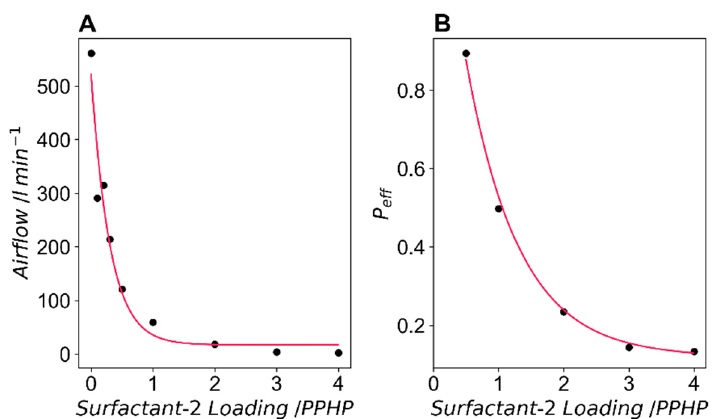
Figure 8. ( A ) Airflow through the foams at constant pressure of 125 Pa as a function of the loading of surfactant-2 where the solid line indicates an exponential fit to the data and ( B ) the calculated effective open cell ratio of the foams as a function of surfactant-2 loading. The solid line indicates an exponential fit to the data.